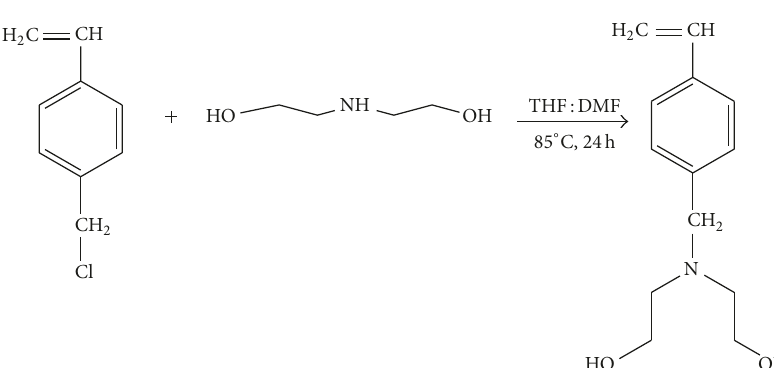
Figure 1: Synthesis reaction of DEAMSt monomer.